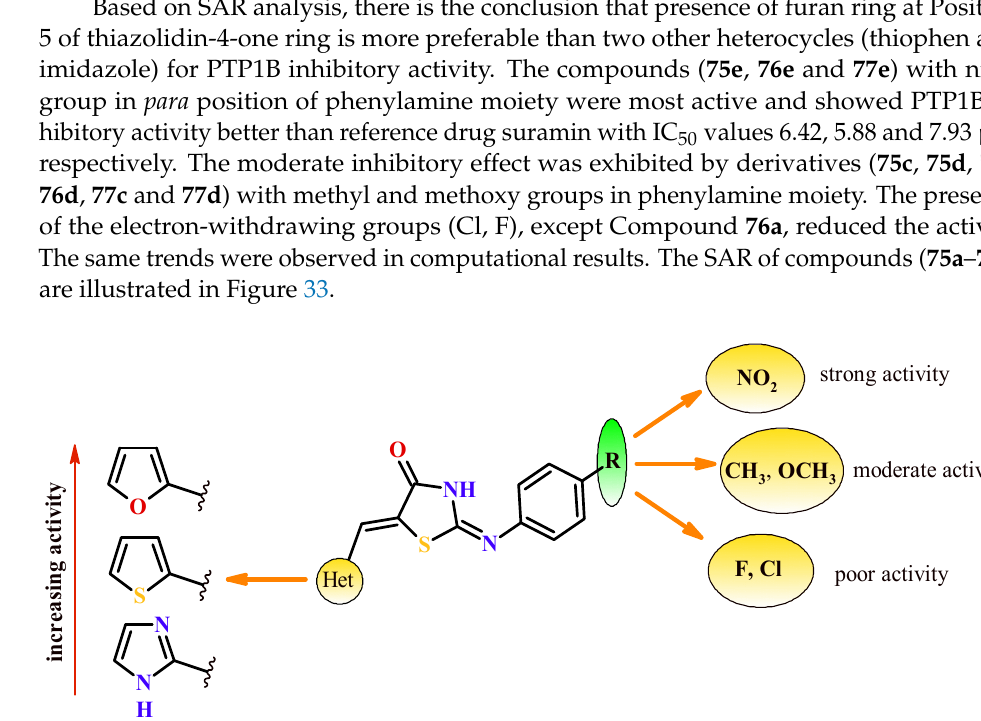
Figure 33. The SAR of different compounds ( 75a – 77e ). Jiang et al. synthesized series of 5-(bromobenzylidene)thiazolidine-2,4-dione deriva- tives and their saturated analogues [83]. The activity of the synthesized derivatives was tested in vitro against recombinant human PTP1B (at a concentration of 20 µ g/mL). Ini- tially, the percent of inhibition for all compounds involved in the experiment was mea- sured. Subsequently, their IC 50 values were determined for best-performing derivatives (>50% inhibition).